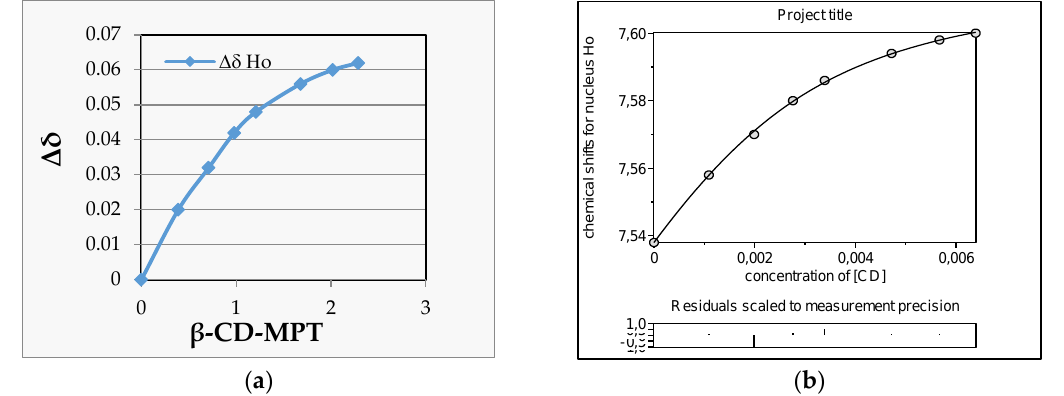
Figure 4. The 1 H NMR titration of MPT with β-CD: ( a ) Chemical shift change of the ortho-protons of the phenyl moiety of MPT with increasing β-CD concentration. Positive values mean downfield shifts. The small complexation induced shift (CIS) observed for the ortho-protons of the phenyl moiety of MPT (0.04 ppm, see Table 1) was particularly significant, indicating that a part of the phenyl ring of MPT entered into the cavity of β-CD. ( b ) Curve-fitting analysis by the HypNMR2008 program.